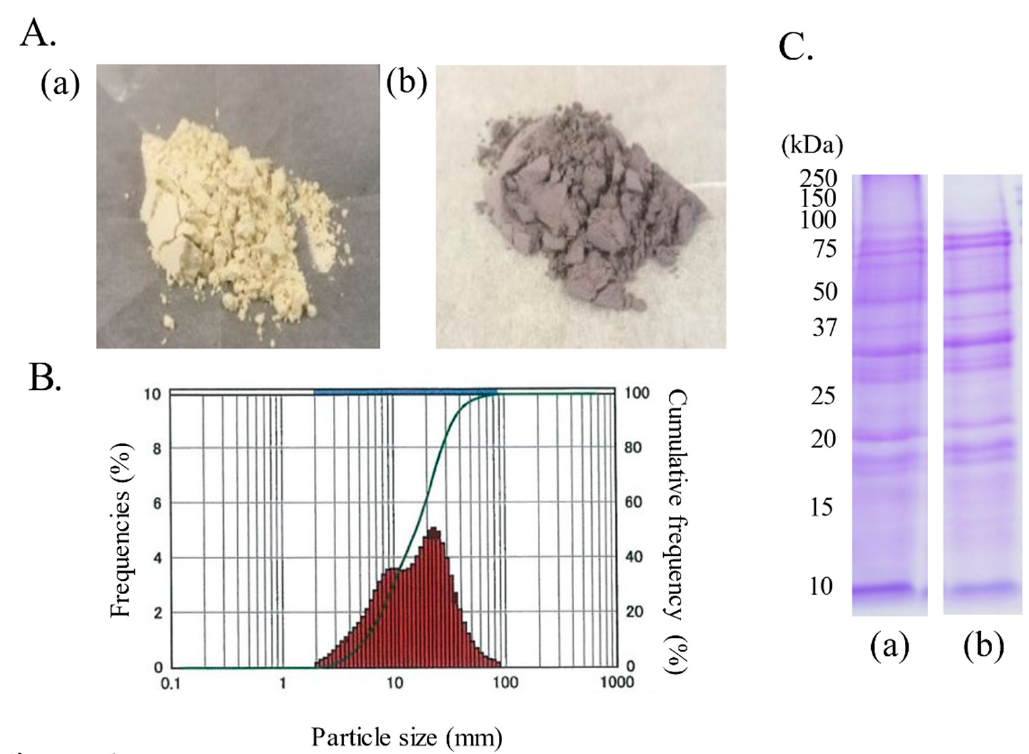
Figure 1. Characterization of black soybean seed coat powder (BSCP) and yellow soybean seed coat powder (YSCP). ( A ) Appearance of BSCP ( a ) and YSCP ( b ). ( B ) Particle size of BSCP. ( C ) Protein patterns of BSCP ( a ) and YSCP ( b ).